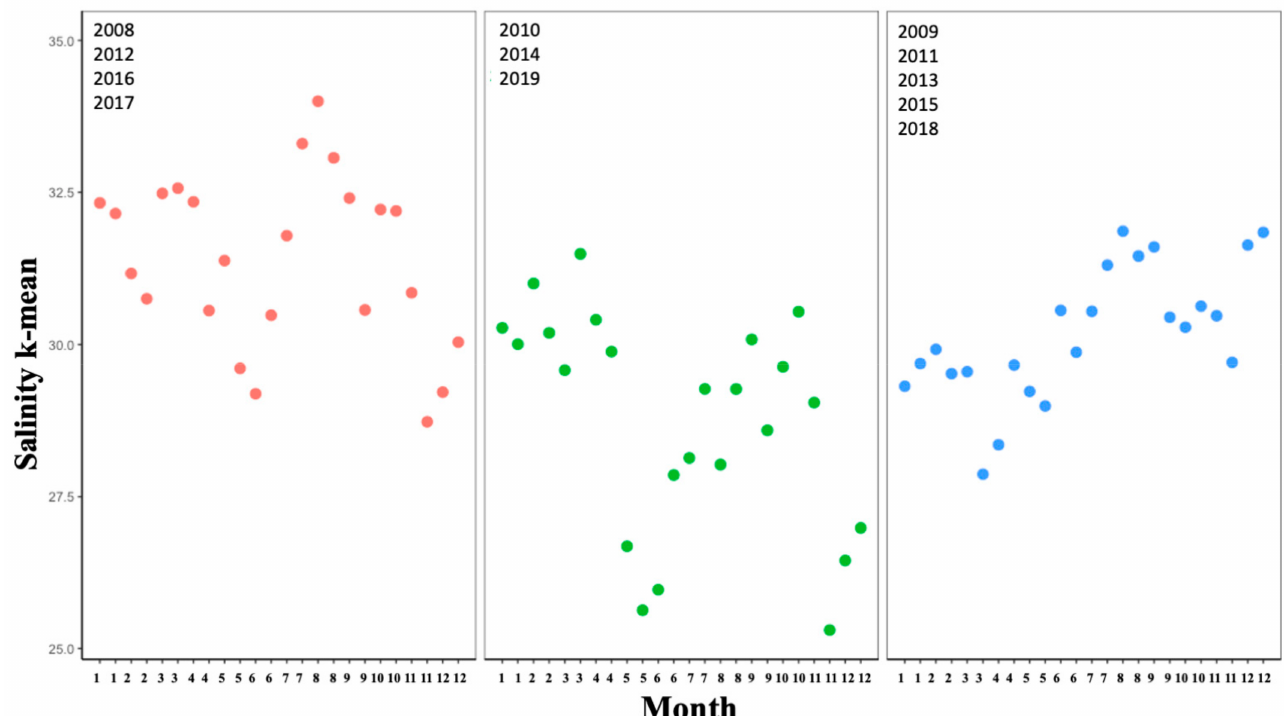
Figure 3. K-means clustering results, showing values of centroids for salinity for each fortnight for each cluster. Years belonging to each cluster are displayed in the top left corner of each